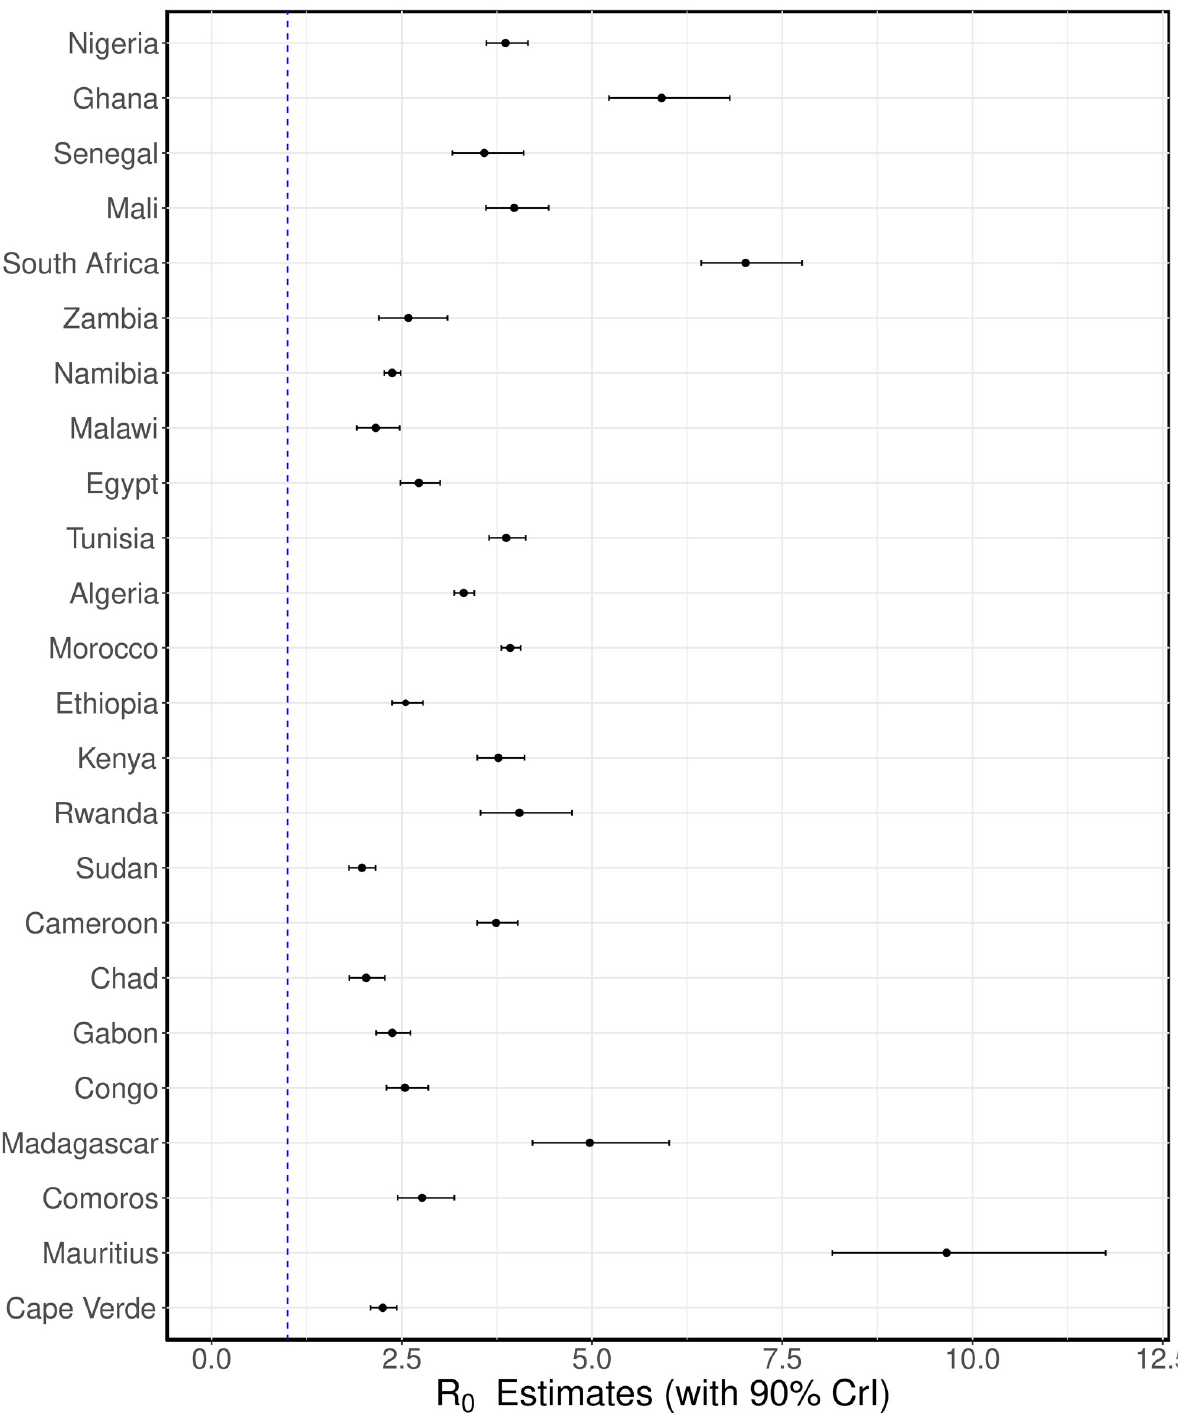
Fig 3. Estimated basic reproduction numbers. The estimated basic reproduction number for each country. The black dots are the median estimates of the reproduction numbers, while the thin bars are 90% credible intervals (CrI).